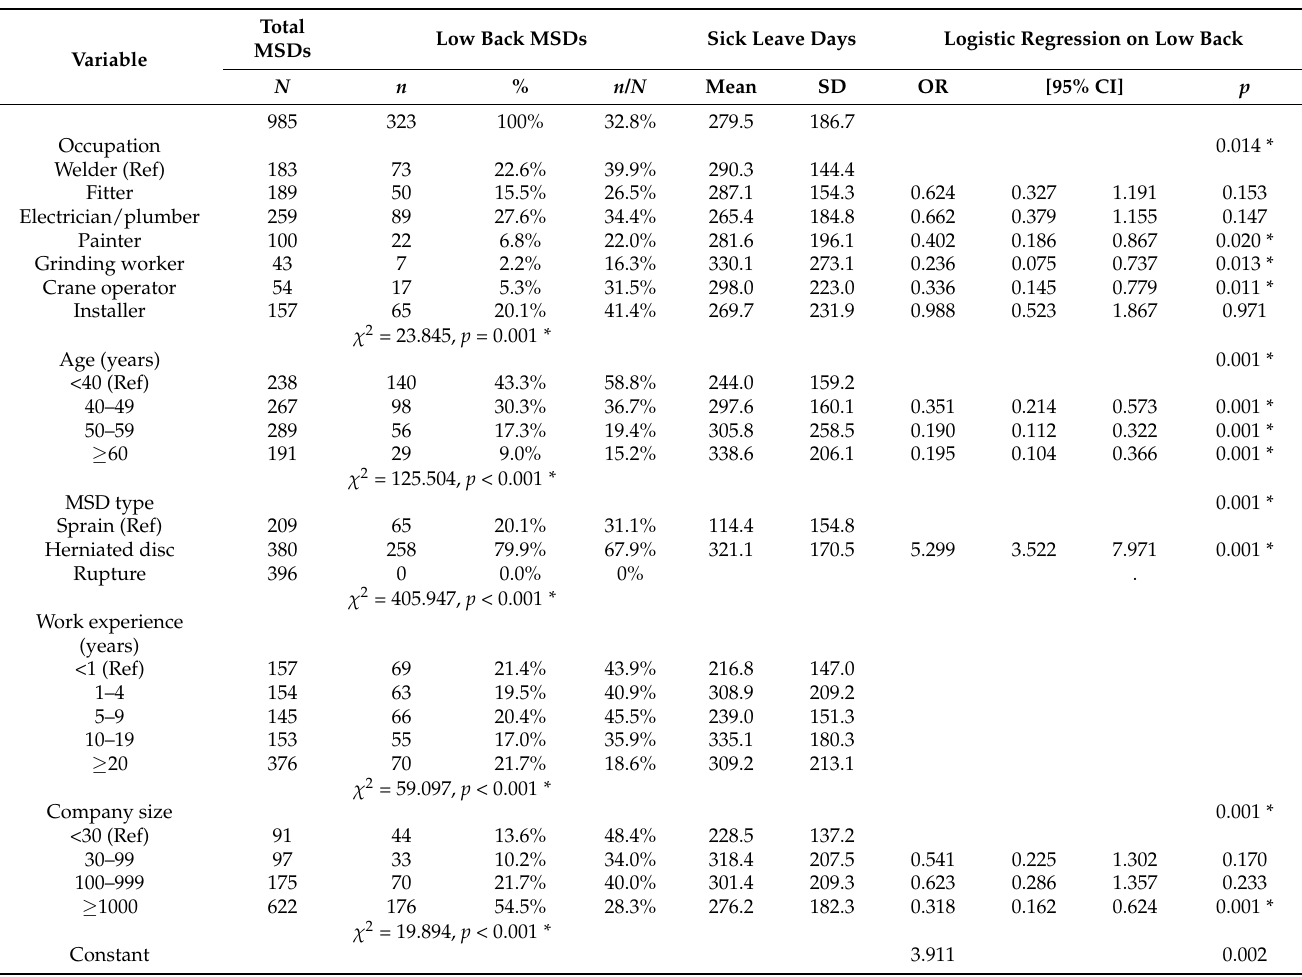
Table 3. Distribution and sick leave days of low back MSDs and factors associated with low back